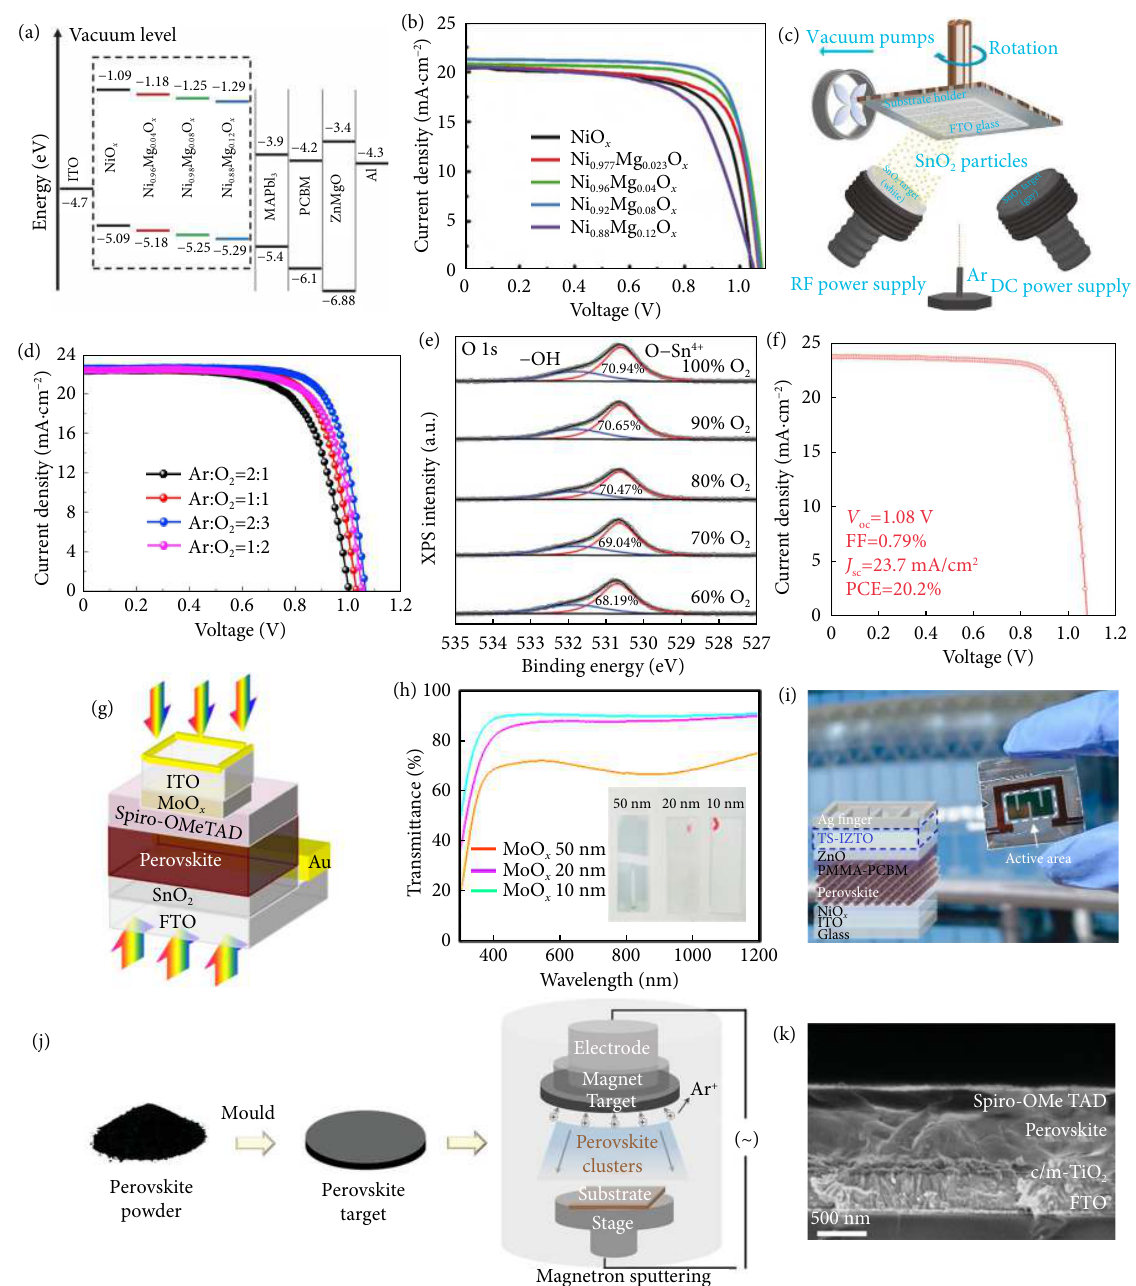
Fig. 7 Applications of magnetron sputtering for fabricating PSCs. ( a and b ) Energy band diagram (a) and current–voltage characteristics (b) of sputtered MgO doped NiO x as ETL (reprinted with permission from ref. [81], © 2017 The Authors). (c) Schematic illustration of SnO 2 deposition process of DC/RF magnetron sput- tering. (d) J – V curves of PSC based on sputtered SnO 2 film with different Ar/O 2 ratio. ( c and d ) Reprinted with permission from ref. [82], © 2019 International Solar Energy Society. (e) XPS O 1s core level of the SnO 2 films deposited with different oxygen ratio. (f) J–V curve of the champion device based on the sputtered SnO 2 ETL and MAPbI 3 perovskite film. (e and f) Reprinted with permission from ref. [83], © 2019 The Authors. (g) Schematic illustration of the semi-transparent PSC with two illumination direction. (h) Transmittance of different thicknesses of MoO x buffer layers. ( g and h ) Reprinted with permission from ref. [74], © 2017 Elsevier Ltd. (i) Photograph and schematic device structure of semi-transparent PSC with ITO anode and IZTO top cathode (reprinted with permission from ref. [85], © 2020 Elsevier Ltd). (j) Scheme of the perovskite layer preparation process via sputtering. (k) Cross-sectional SEM image of PSCs produced via magnetron sputtering. ( j and k ) Reprinted with permission from ref. [87], © 2021 The